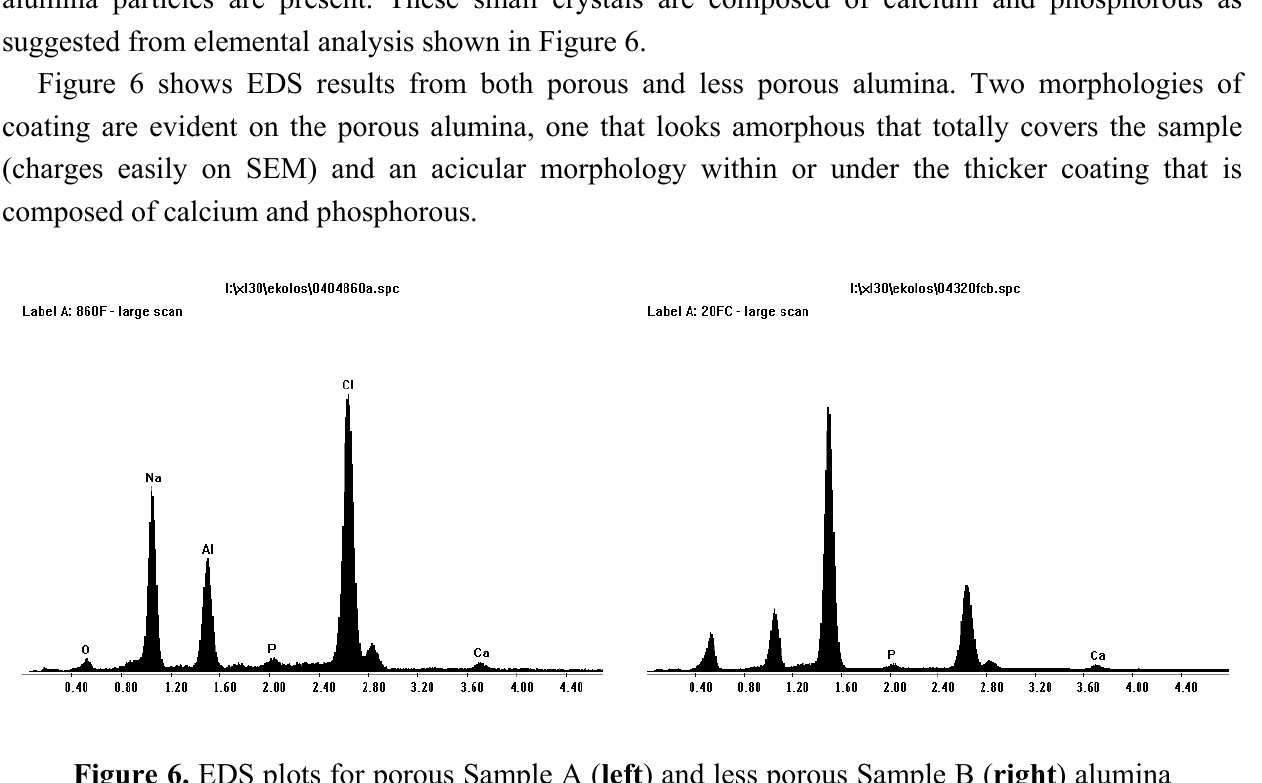
Figure 6. EDS plots for porous Sample A ( left ) and less porous Sample B ( right ) alumina after SBF coating. Calcium and phosphorous are